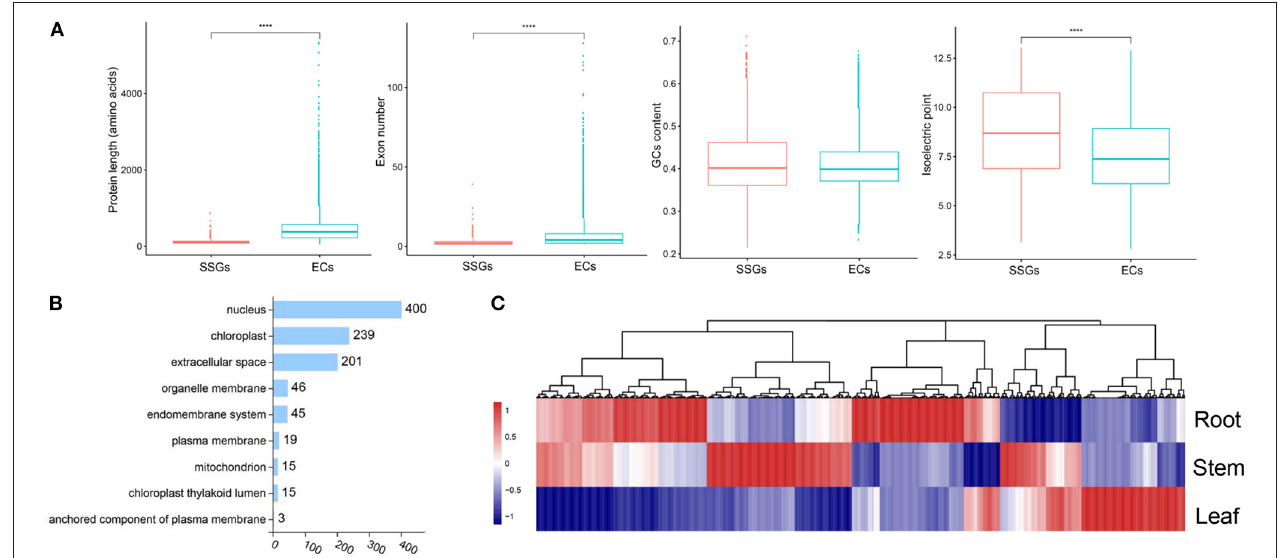
FIGURE 5 | Analysis of lineage-specific genes (LSGs) in S. cusia . (A) Box-plot comparisons of protein length, exon number, GC content, and isoelectric point for the Strobilanthes -specific genes (SSGs) and evolutionarily conserved genes (ECs) in the S. cusia . SSGs mean the S. cusia LSGs; ECs mean the S. cusia evolutionary conserved genes. (B) Number of SSGs assigned to different subcellular locations. (C) Expression pattern of SSGs in the roots, stems, and leaves at three developmental stages.